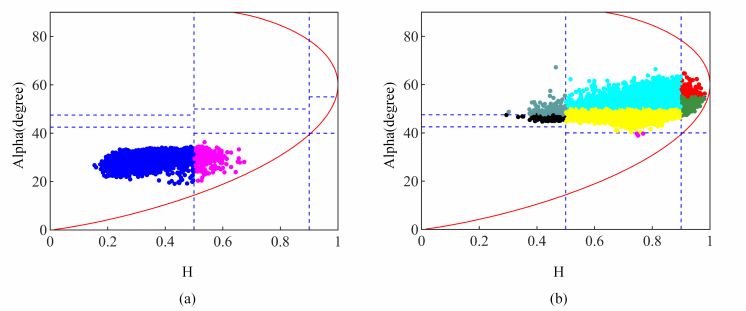
Figure 10. The ( a ) surface-dominated and ( b ) volume-dominated targets extracted from the uncali- brated CQP SAR data in Section 4.1. Different point colors represent different areas in the H / α